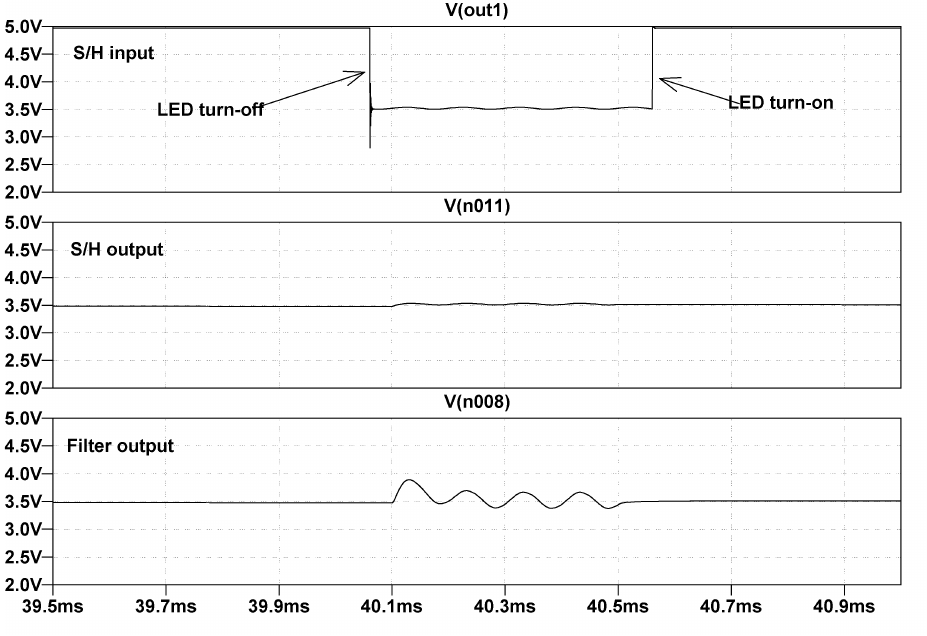
Figure 6. Simulation